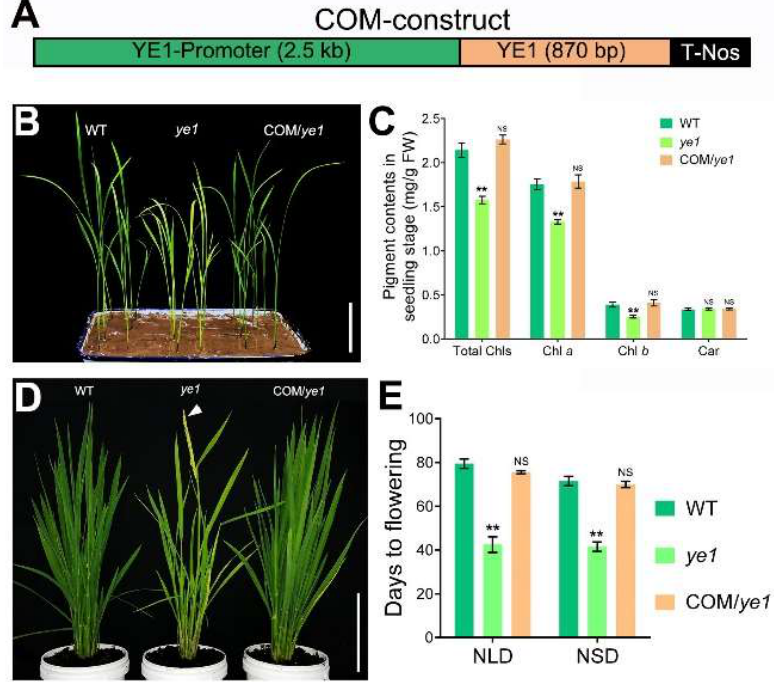
Figure 4. Complementation of ye1 mutant. ( A ) The construct for complementary analysis of YE1 gene. ( B ) Leaf color phenotypes of WT, ye1 and complementary plants (COM/ ye1 ). Bar = 5 cm. ( C ) Comparisons of pigment contents of WT, ye1 and complementary plants. ( D ) Flowering time phenotypes of WT, ye1 and complementary plants under NLDs, when ye1 was heading. The arrow indicates the flower. Bar = 25 cm. ( E ) Days to flowering of WT, ye1 and complementary plants under NLDs and NSDs. Each value is given as means ± SD ( n = 3). NS, no significant change. * ( p < 0.05) and ** ( p < 0.01) indicate significant differences compared with WT (Student’s t -test).